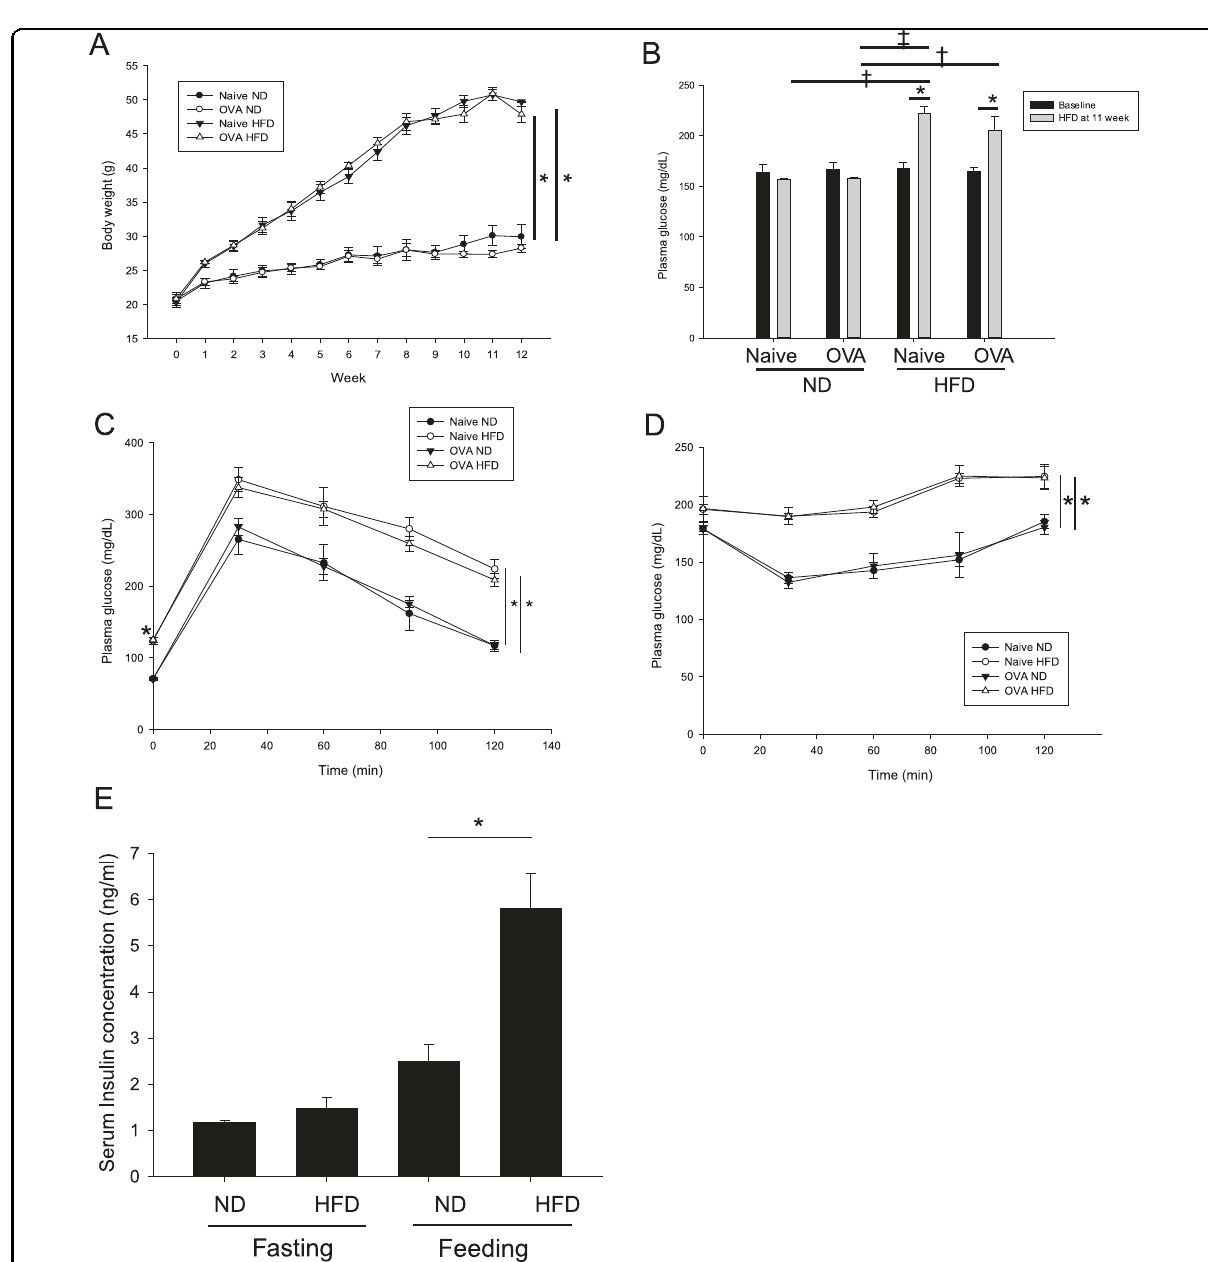
Fig. 2 Physiologic and metabolic changes of studied groups. Comparisons of body weight ( a ), blood glucose levels ( b ), the results of an oral glucose tolerance test ( c ) performed during the 10th week of HFD feeding, and an insulin tolerance test performed during the 11th week of HFD feeding ( d ) between HFD mice and ND mice. Serum insulin concentrations were measured during the 12th week of HFD feeding. † P < 0.05; ‡ P < 0.01; * P < 0.001. HFD high-fat-diet, ND normal